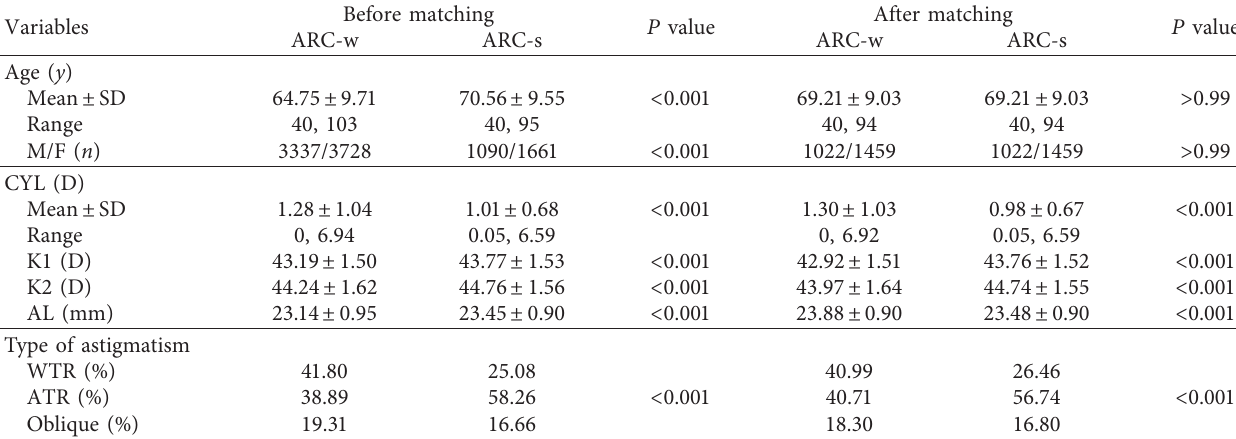
Table 3: Demographic characteristics of the 2 ARC groups before and after matching for corneal astigmatism.